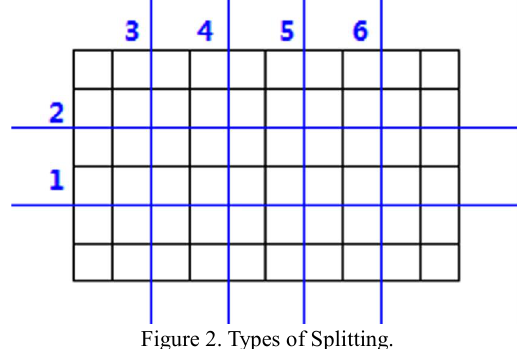
Figure 2. Types of